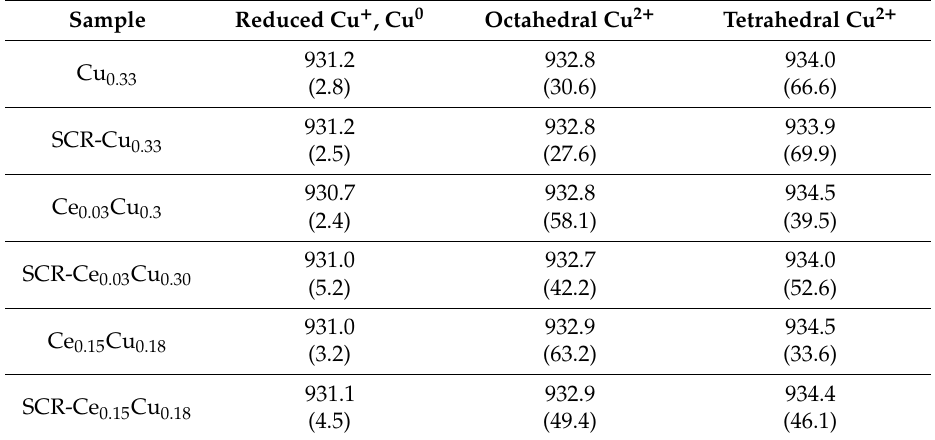
Figure 7. Cu 2p XPS spectra of Cu–Al parent spinels and doped with cerium for fresh and used catalysts. Table 4. Spectral fitting parameters for Cu 2p 3/2 : binding energy (eV) and percentage of total area.